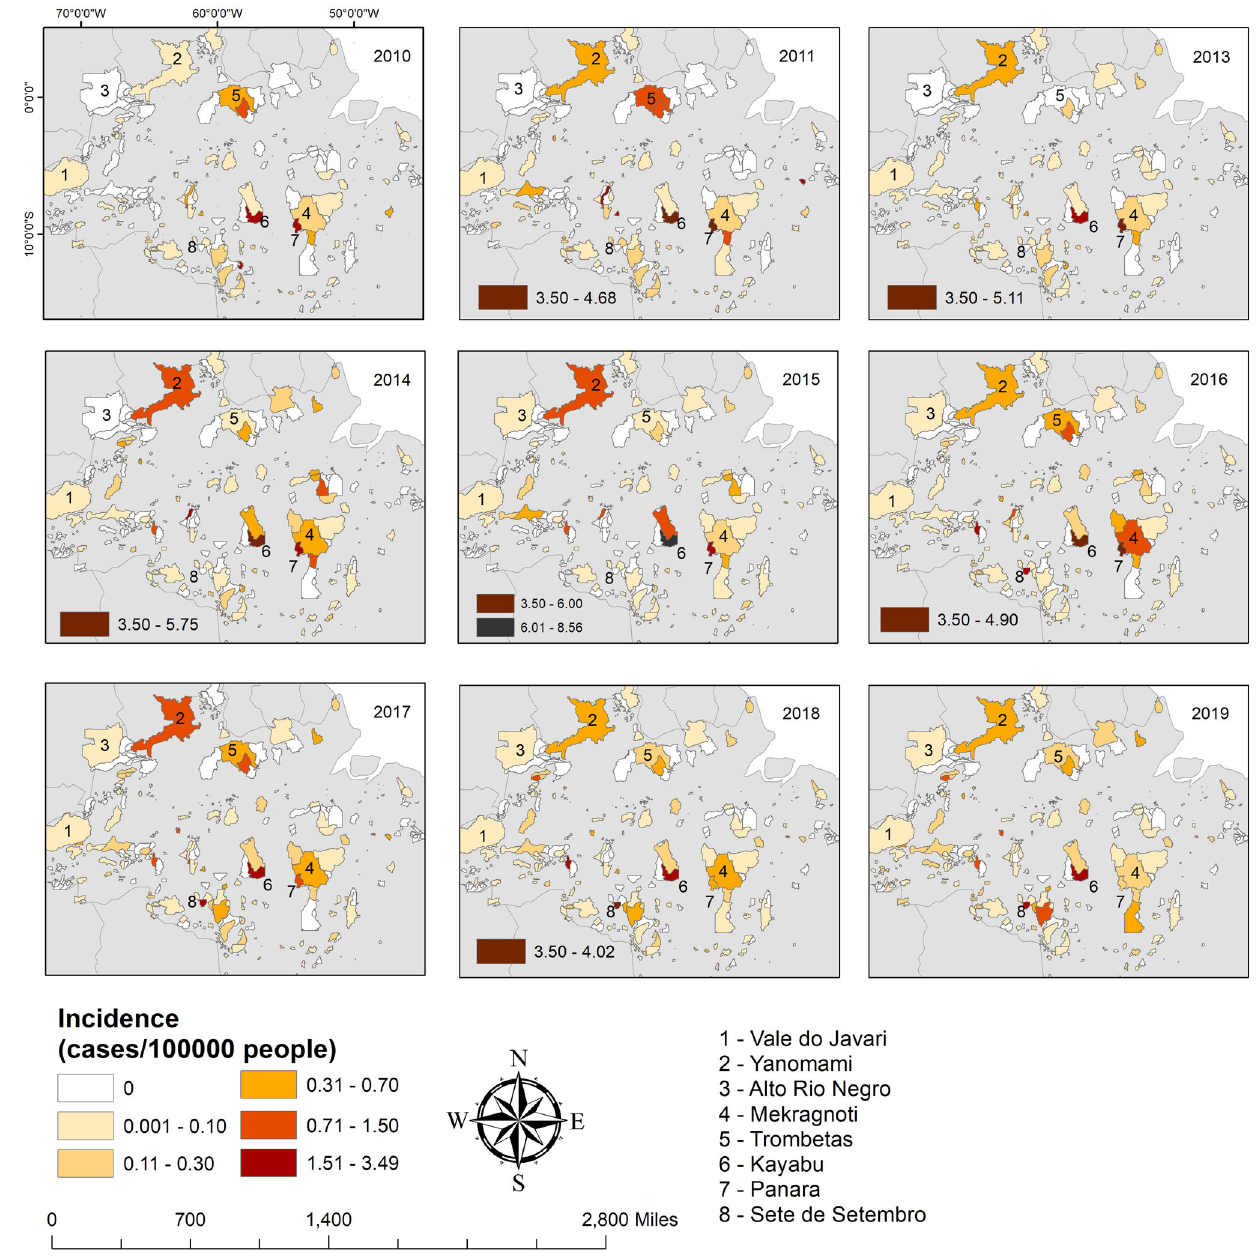
Fig. 3 Fire-related disease incidence for Indigenous people. Incidence of respiratory and cardiovascular diseases and infections for the Indigenous territories, from 2010 to 2019. The Indigenous territories 1 – 5 listed on the maps are the ones with the highest PM 2.5 absorption capacity, and numbers 6 – 8 are the territories with the highest incidences.